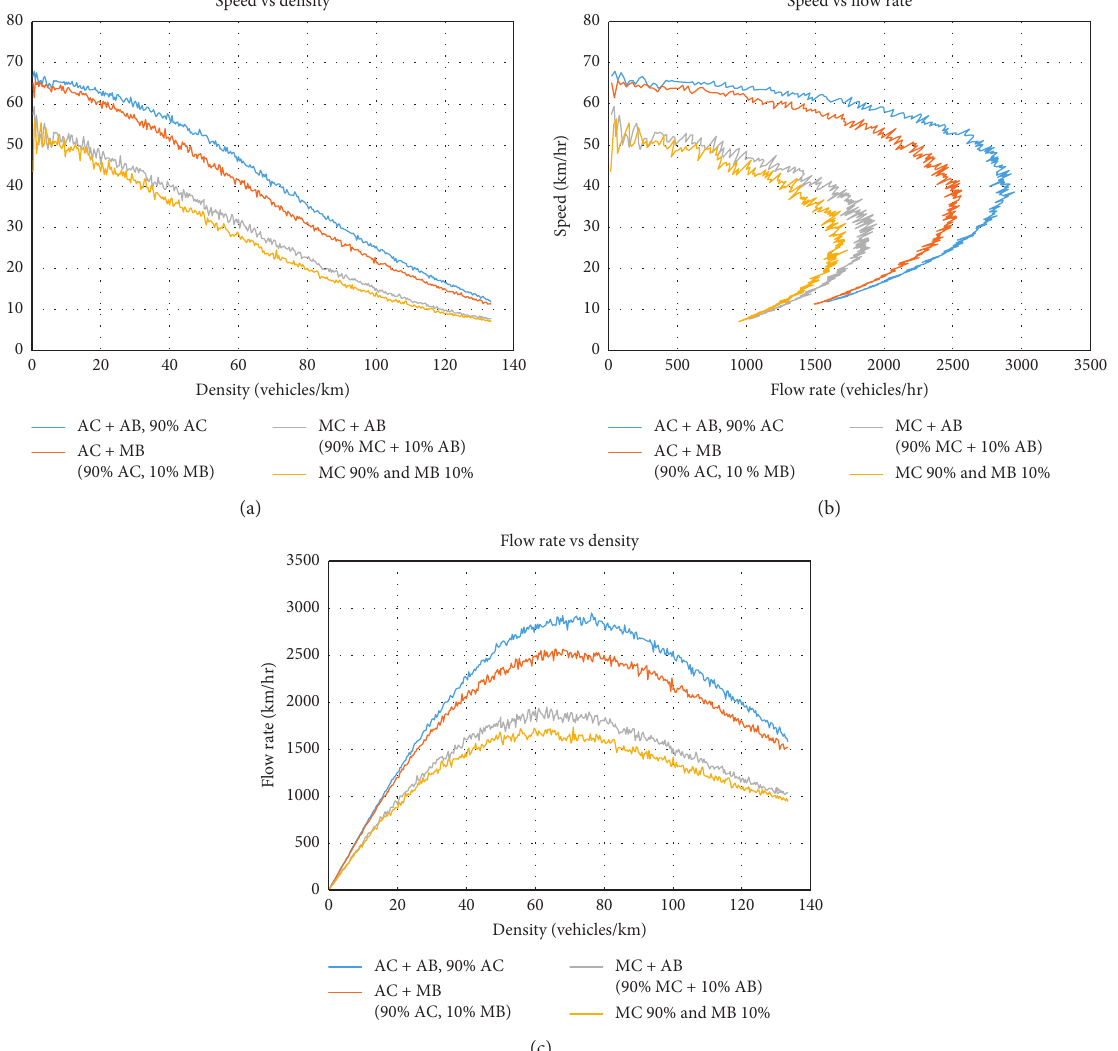
Figure 6: Traffic flow fundamental diagrams for different compositions of AC, MC, AB, and